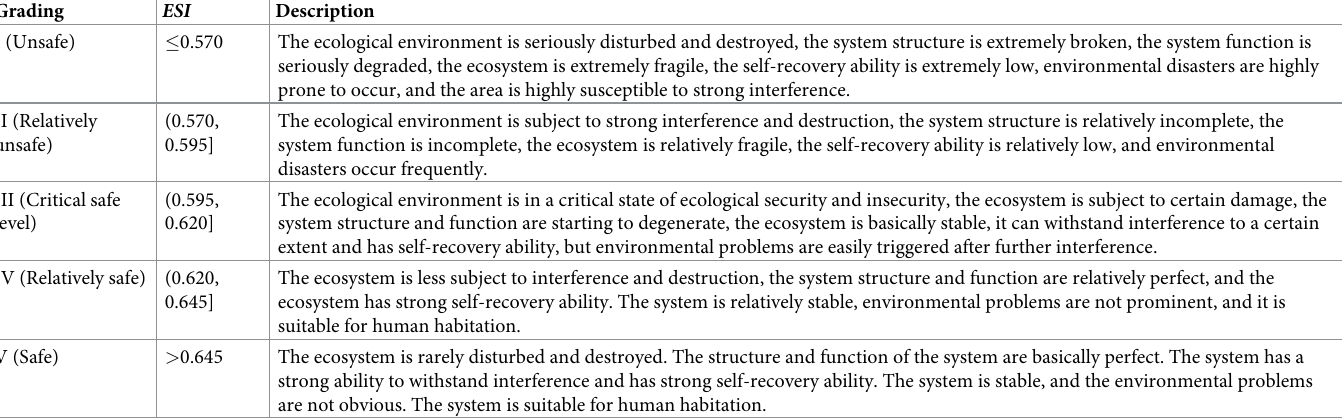
Table 2. Grading standard of ecological security in CYP.